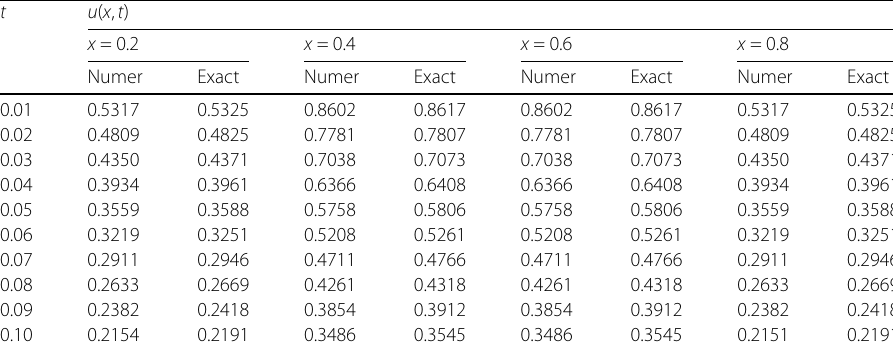
Table 4 Comparison of numerical and analytical results for Example 6.2 t u ( x , t ) x = 0.2 x = 0.4 x = 0.6 x = 0.8 Numer Exact Numer Exact Numer Exact Numer Exact 0.01 0.5317